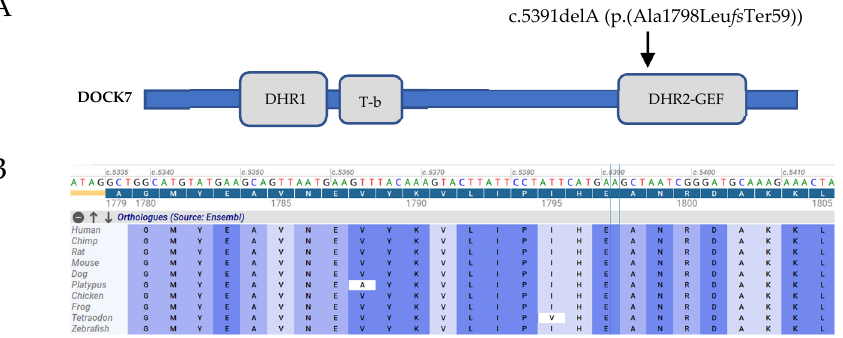
Figure 3. ( A ) Schematic of DOCK7 showing the relative location of the frameshift variant c.5391delA in Exon 42 (NM_001271999.1). DOCK homology domains DHR1 (amino acids 516–727) and DHR2 (amino acids 1668–2110) and TACC3-binding region (T-b). ( B ) Evolutionary conservation of the frameshift variant among 10 vertebrates.